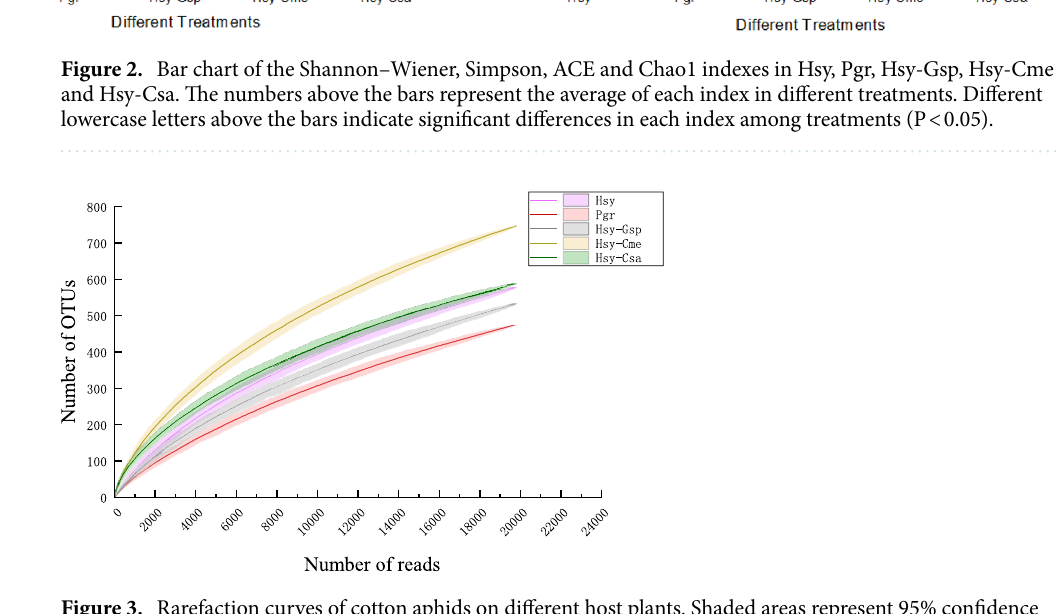
Figure 3. Rarefaction curves of cotton aphids on different host plants. Shaded areas represent 95% confidence